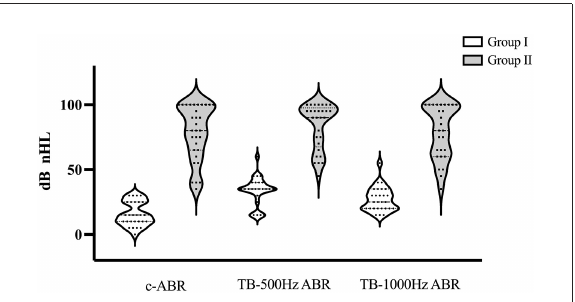
FIGURE1 Hearing distributions in Group I and Group II. If there was no response at 95 dB nHL, a threshold of 100 dB nHLwas assumed. c-ABR, click-evoked Auditory Brainstem Response; TB-ABR, Tone-burst Auditory Brainstem Response.